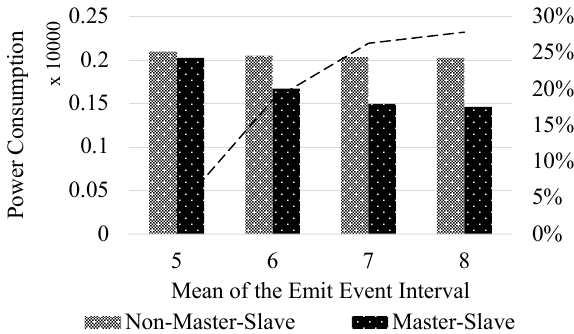
Figure 7. Total power consumption of the edge nodes.